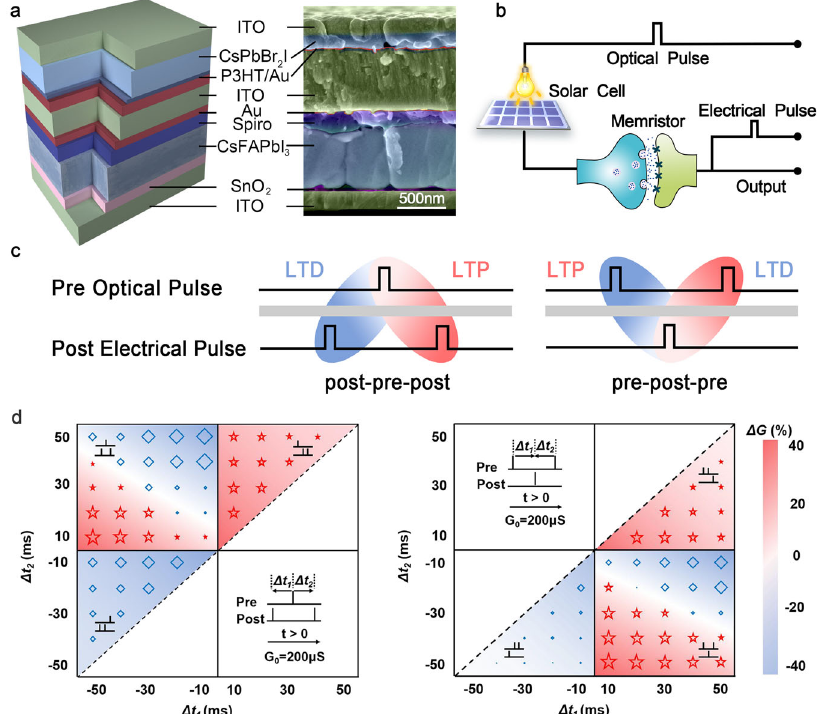
Fig. 3 | The triplet-STDP implement of self-power memristor under light sti- muli. a The schematic and the cross-sectional SEM image of self-powered mem- ristor. b Circuitdiagramofself-poweredmemristorforrealizingtriplet-STDP. c The schematic of the typical triplet-STDP, including ‘ post-pre-post ’ and ‘ pre-post-pre ’ pulse sequences. d The triplet-STDP simulation based on self-powered